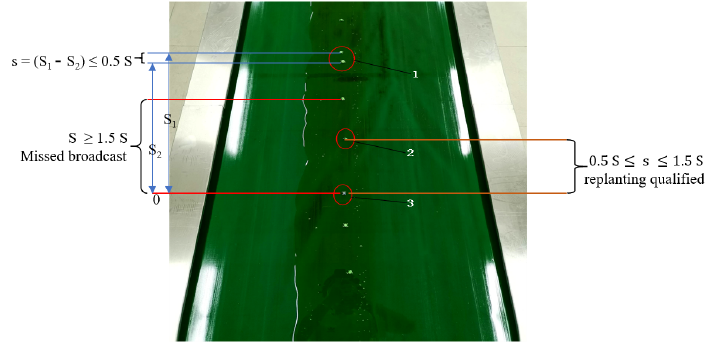
Figure 12. The seed sequence.